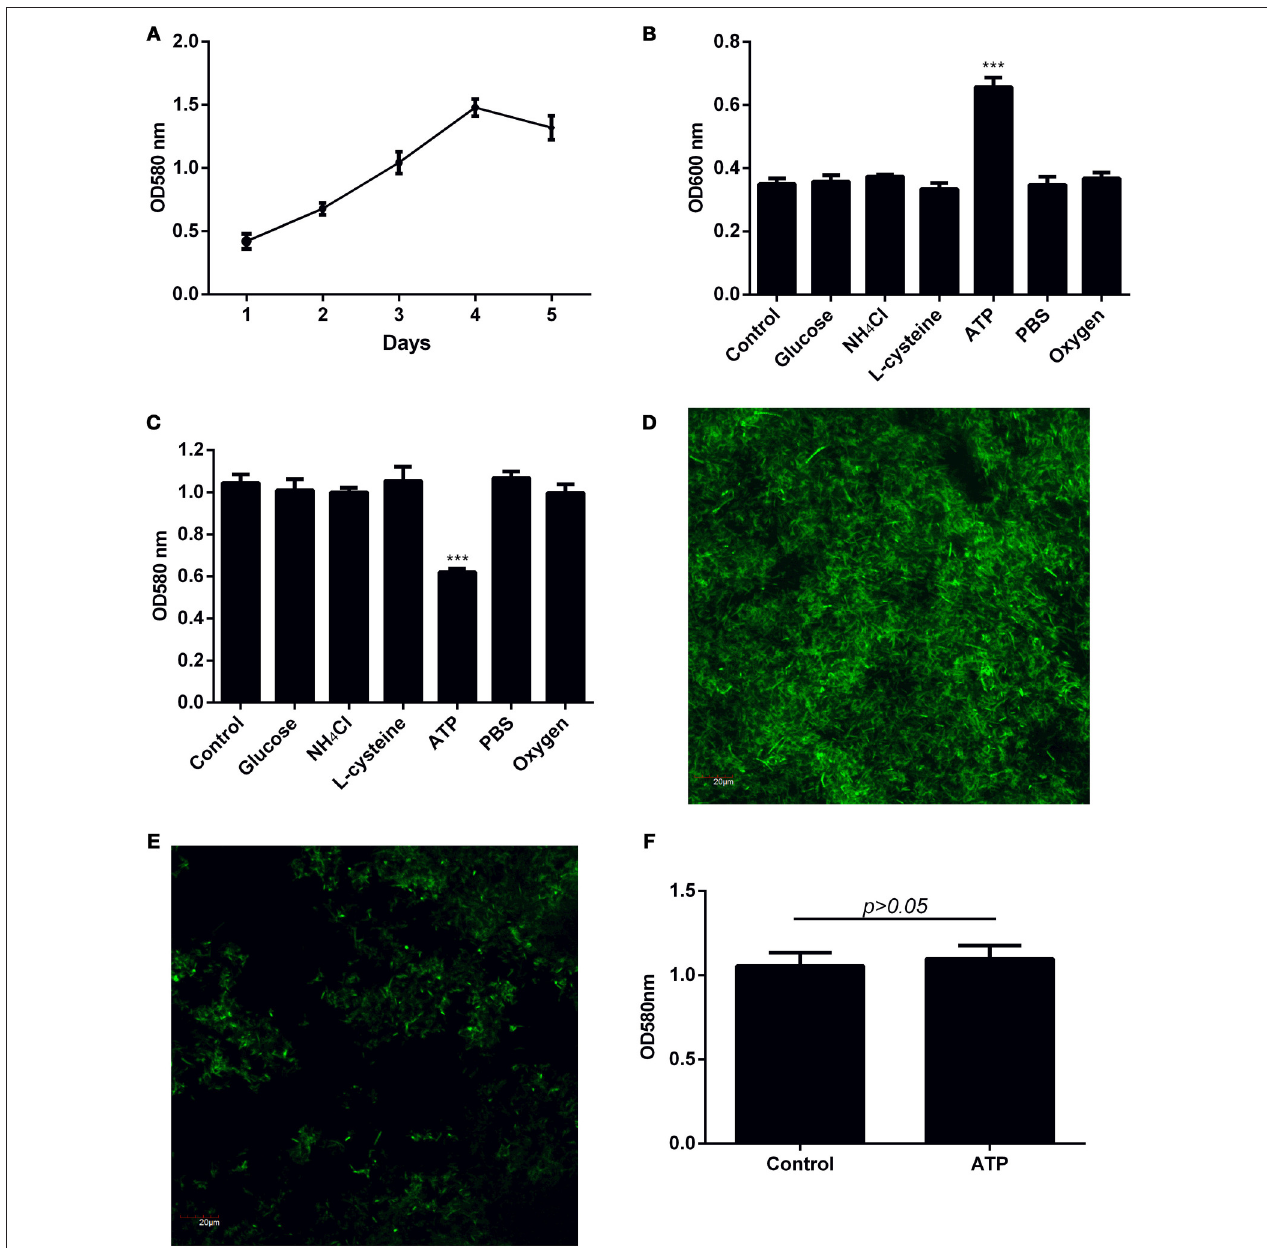
FIGURE 1 | Investigation of factors inducing dispersal of F. nucleatum biofilm. (A) The amount of biofilm formed over a 5-day period was quantified by crystal violet assay. (B) Four-day old F. nucleatum biofilm was left untreated (control) or treated with 2 mM D-glucose, 20 mM NH 4 Cl, 8 mM L-cysteine, 1 mM ATP or PBS, and incubated anaerobically at 37 ◦ C for 1h. A separate plate of 4-day old F. nucleatum biofilm was incubated at 37 ◦ C for 1h aerobically ( ∼ 20% atmospheric O 2 ). The amount of dispersed bacteria was determined by measuring optical density of bacteria in the culture supernatant. (C) The amount of biofilm biomass after induction of dispersal was quantified by crystal violet assay. Biofilm grown on cover slips in 24 well plates was left (D) untreated or (E) treated with ATP for 1 h. The amount of remaining biofilm was visualized by CLSM following staining with SYTO 9. Magnification 60X, scale bar: 20 µ m. (F) F. nucleatum biofilm was cultured in the presence of 1 mM ATP for 4 days with daily change of media. The amount of biofilm formed was quantified by crystal violet assay. The data presented were obtained from one representative experiment carried out in triplicate. All experiments were performed 3 independent times and showed similar trends (Supplementary Figure 1). *** p <